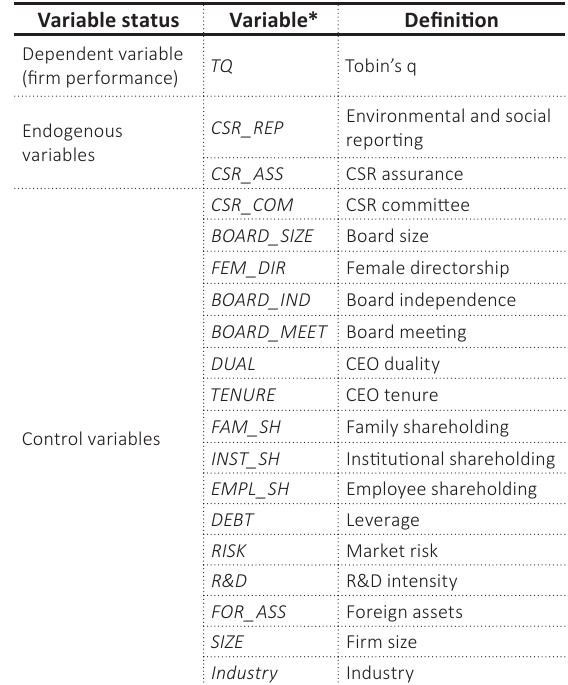
Table 1. Variables used in the regression